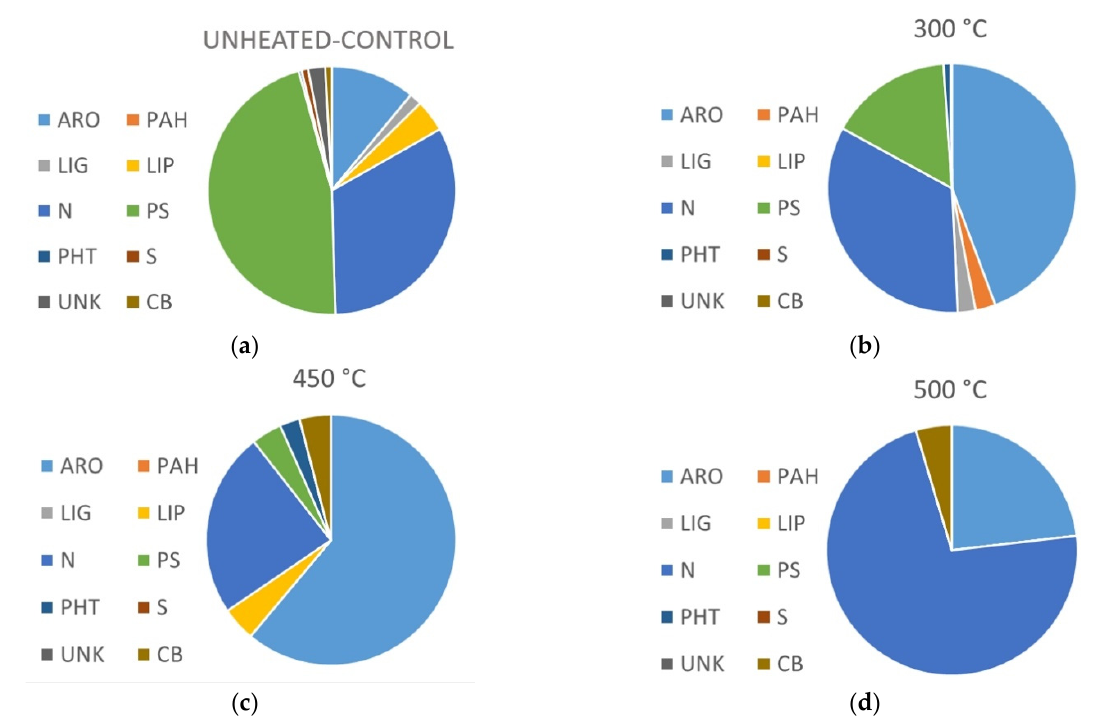
Figure 3. Composition of the pyrolysates of unheated control ( a ), heated at 300 ( b ), 450 ( c ), and 500 °C ( d ) with an indication of their probable origin: ARO: aromatic and hydroaromatic; PAH: polycyclic aromatic hydrocarbons; LIG: lignin derivatives; LIP: lipids; N: nitrogenous; PHT: phthalates (contaminant); S: sulfur; UNK: unknown; and CB: column bleed.